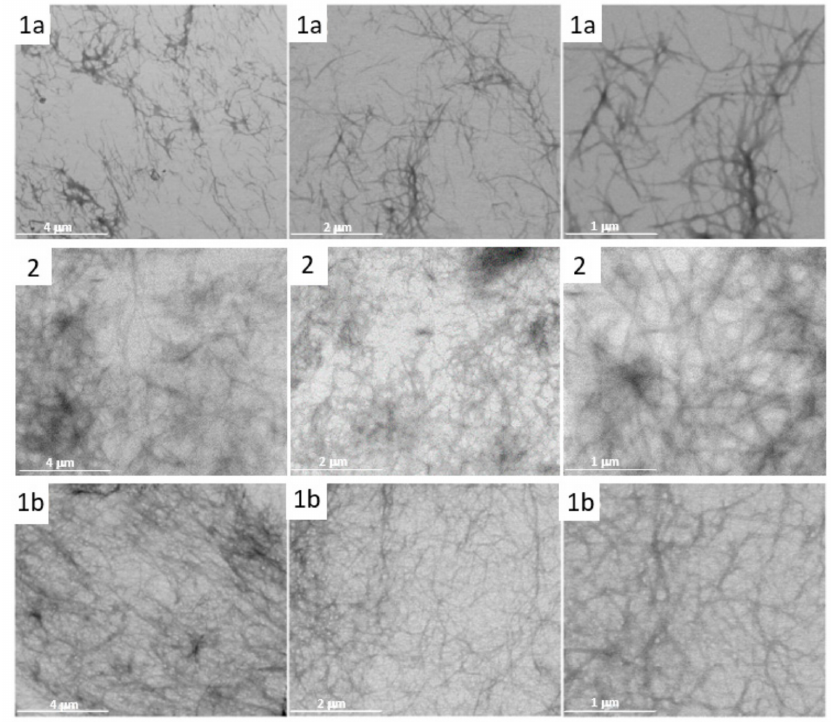
Figure 7. Comparison of scanning transmission electron microscopy (STEM) images of hydrogels 1a (top), 2 (centre), and 1b at 0.4 wt.%, at different